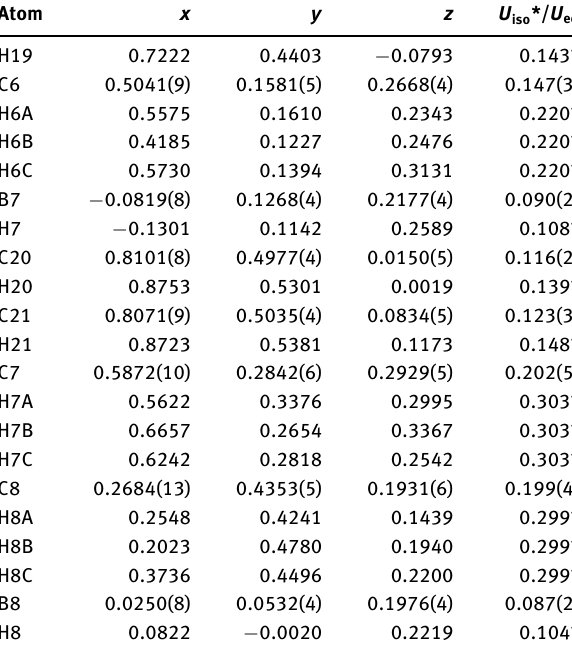
Table 2: Fractional atomic coordinates and isotropic or equivalent isotropic displacement parameters (Å 2